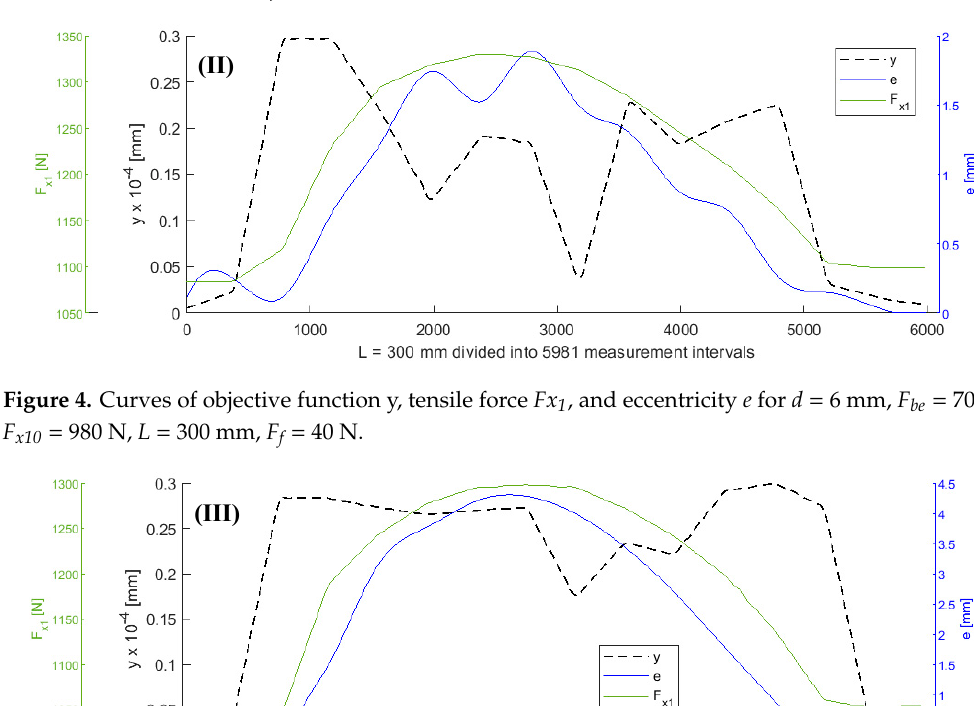
Figure 3. Curves of objective function y, tensile force Fx 1 , and eccentricity e for d = 6 mm, F be = 49 N , Fx 1 = 980 N, L = 300 mm, F f = 30 N.